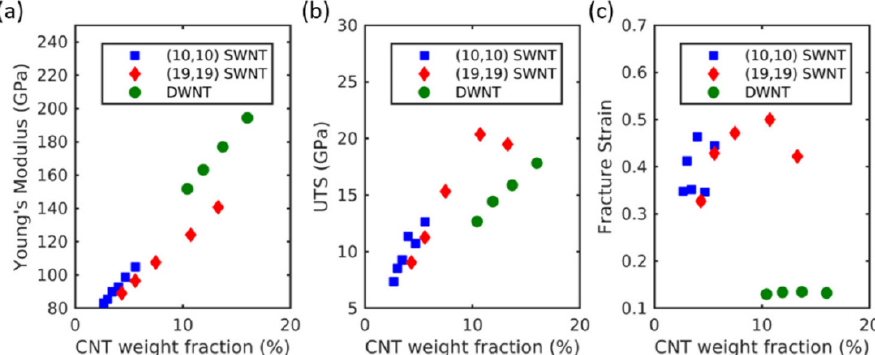
Figure 5. Improvement in mechanical properties of CNT–Al composites as a function of CNT weight fraction: ( a ) Young’s modulus; ( b ) ultimate tensile strength; ( c ) fracture strain. Key for abbreviations: single-wall carbon nanotube (SWNT), double-wall carbon nanotube (DWNT)